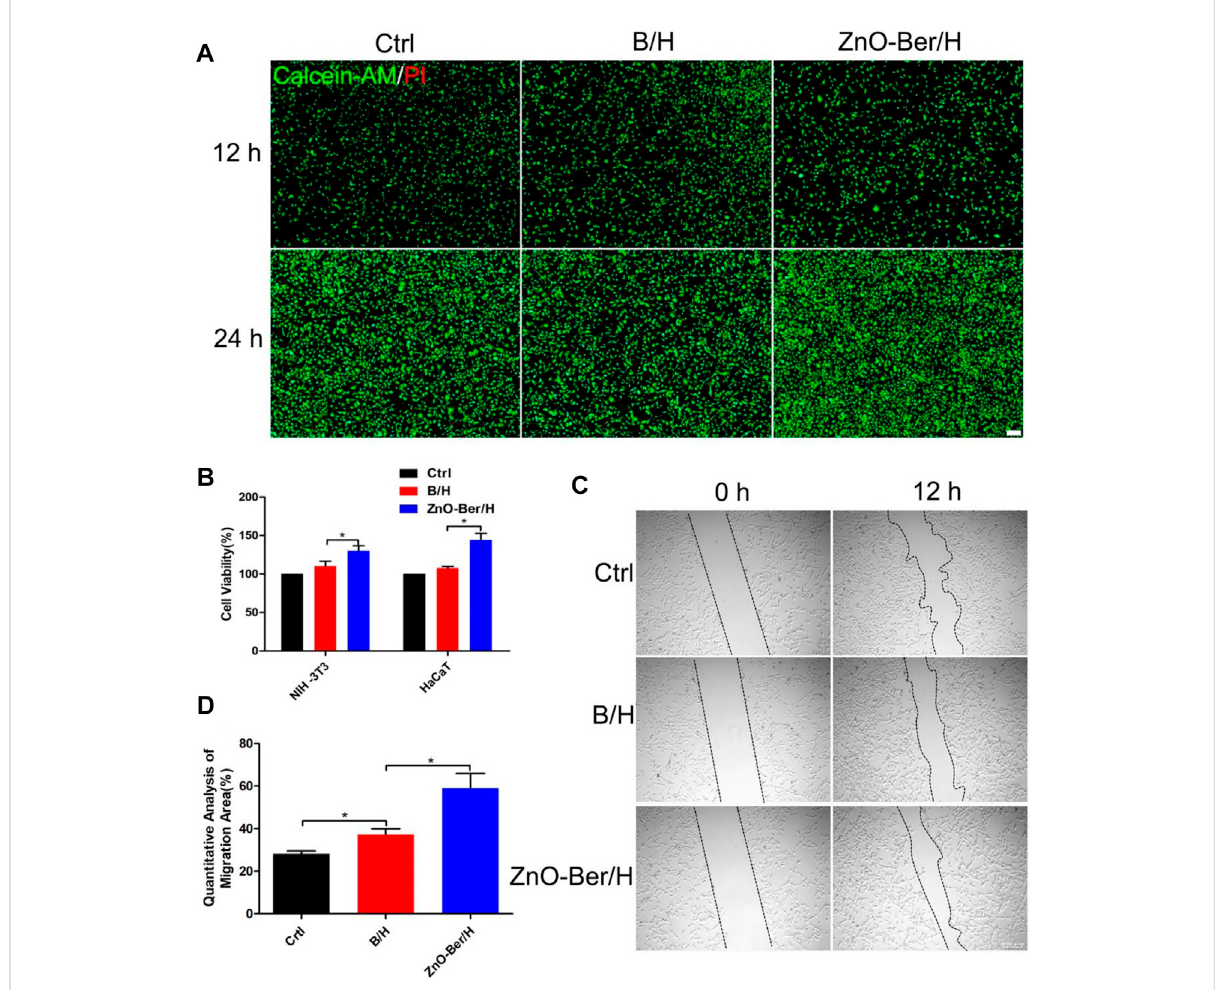
FIGURE 2 Biocompatibility of the ZnO-Ber/H. (A) The cytotoxicity of the Control, B/H and ZnO-Ber/H was determined by live and dead staining at 12 and 24 h (B) CCK-8 analysis in control groups, B/H group and ZnO-Ber/H group. (C) The scratch-wound assay in control groups, B/H group and ZnO- Ber/H group. (D) Migration rates analysis. Statistical analysis: * p ≤ 0.05, ** p ≤ 0.01 (Scale bar:100 μ